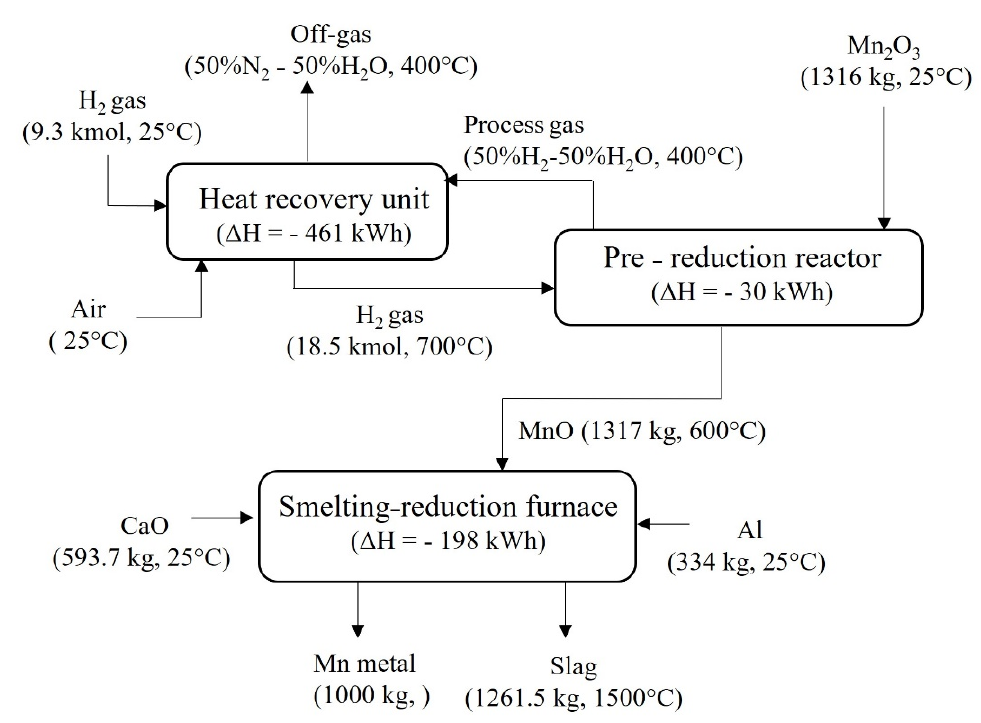
Figure 7. Mass and energy balances for the different units of HAlMan process for Mn metal produc- tion.